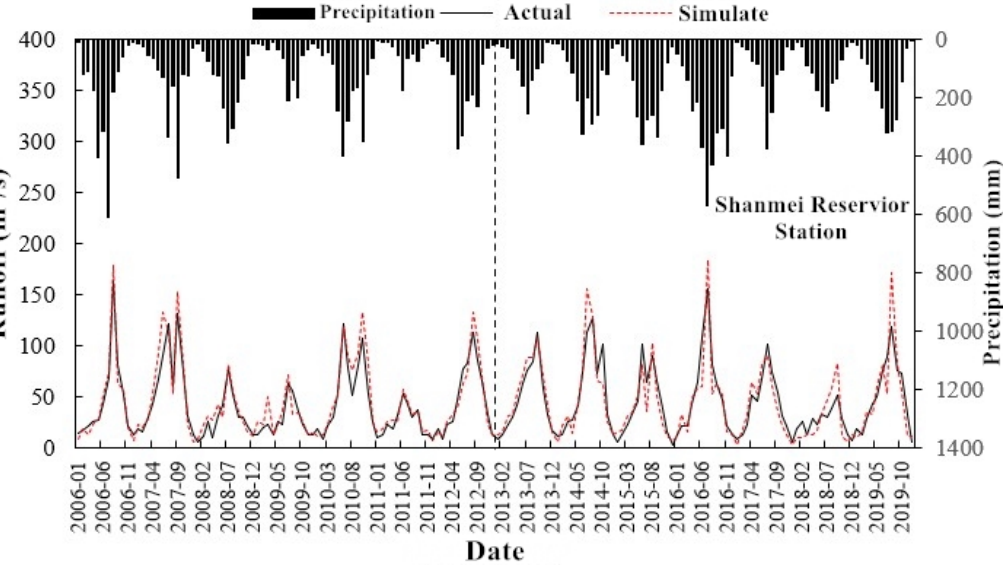
Figure 7. Comparison of measured and simulated runoff data for the Shanmei Reservoir hydrological station in the Jinjiang watershed.